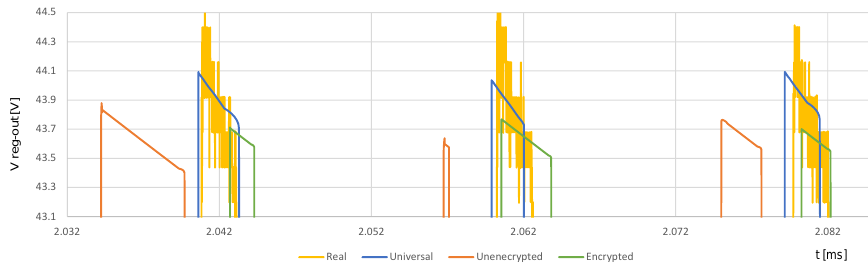
Figure 14. V reg-out models and real measurement time graph curves.